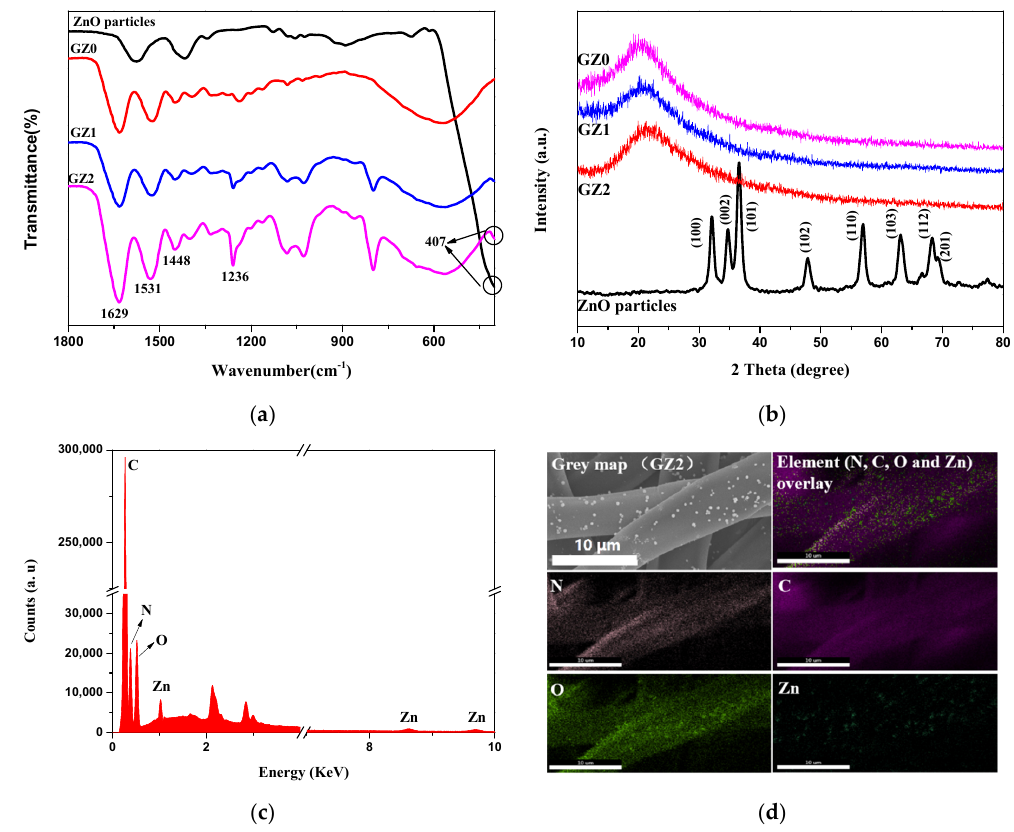
Figure 6. ( a ) FTIR spectra of ZnO particles, GZ0, GZ1 and GZ2, ( b ) XRD patterns of ZnO particles, GZ0, GZ1 and GZ2, ( c ) energy dispersive X-ray spectroscopy (EDX) analysis of GZ2, and ( d ) EDX mapping of GZ2.